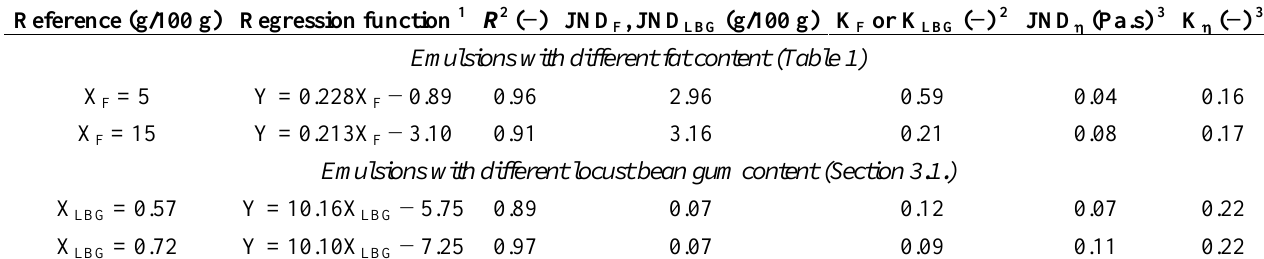
Table 4. Just noticeable differences for creaminess expressed as fat (JND gum (JND ) or viscosity (JND ), and corresponding Weber fractions LBG η